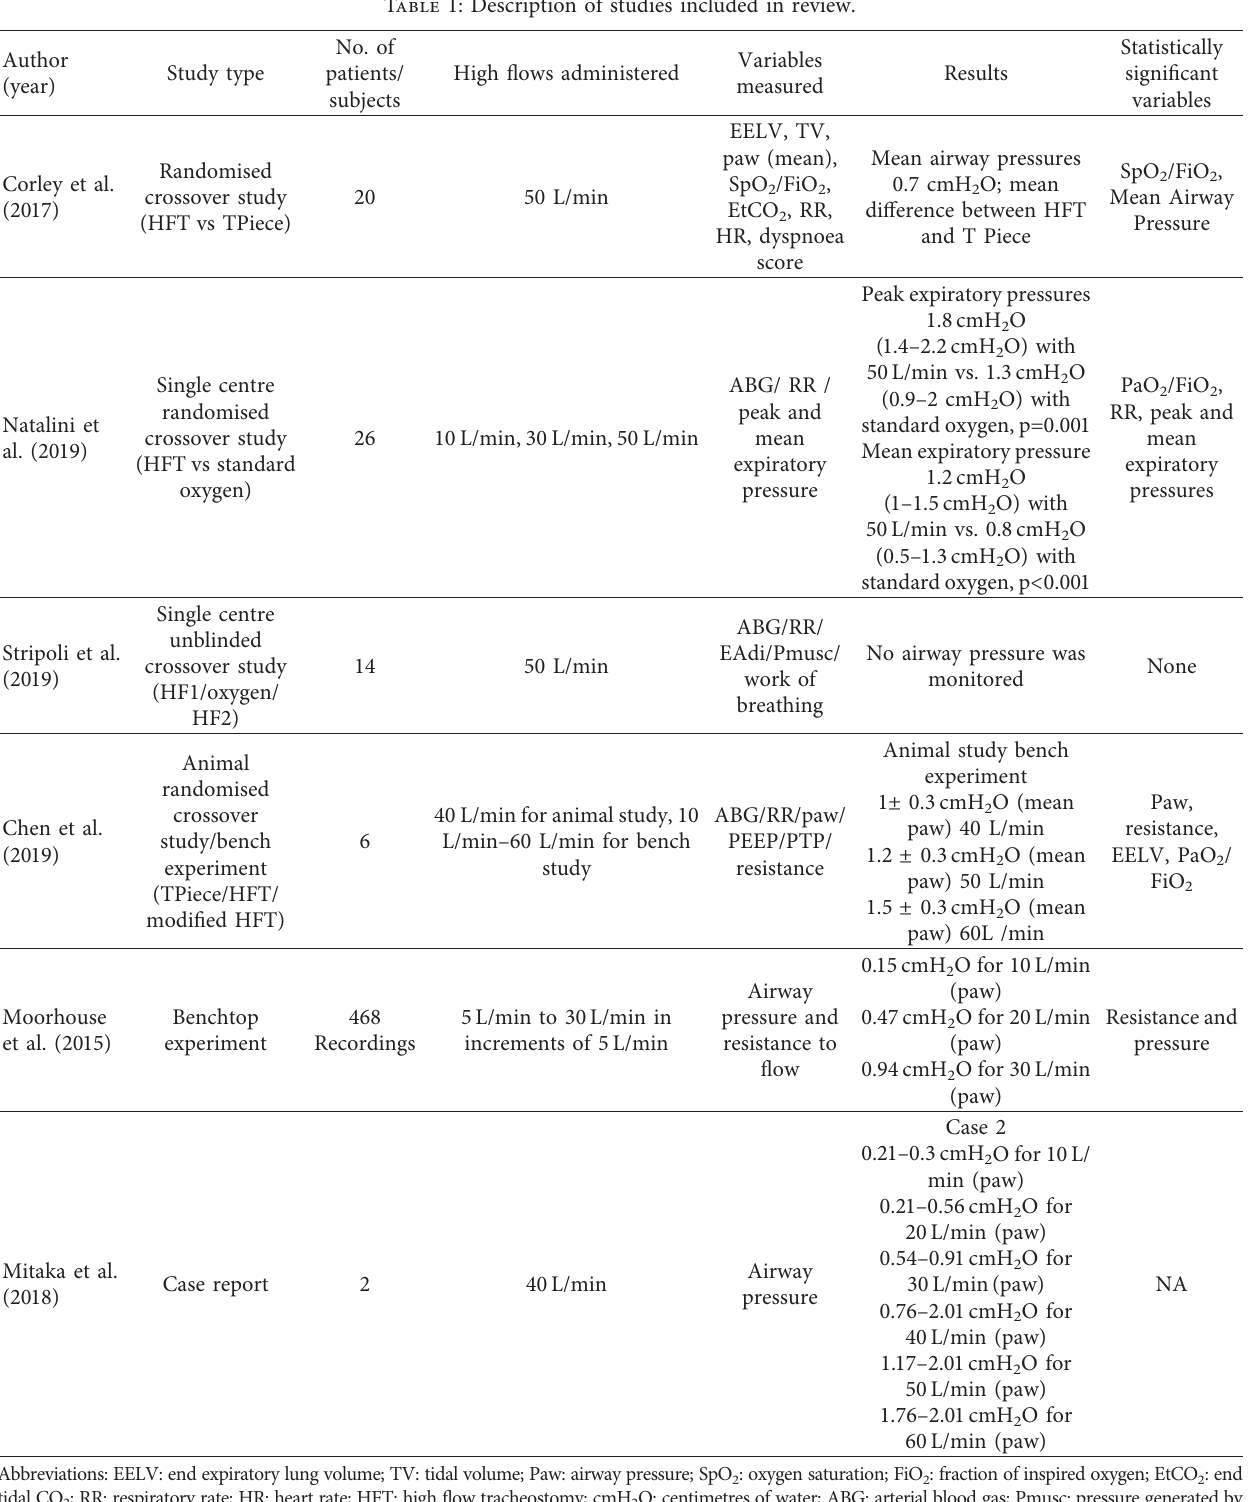
Table 1: Description of studies included in